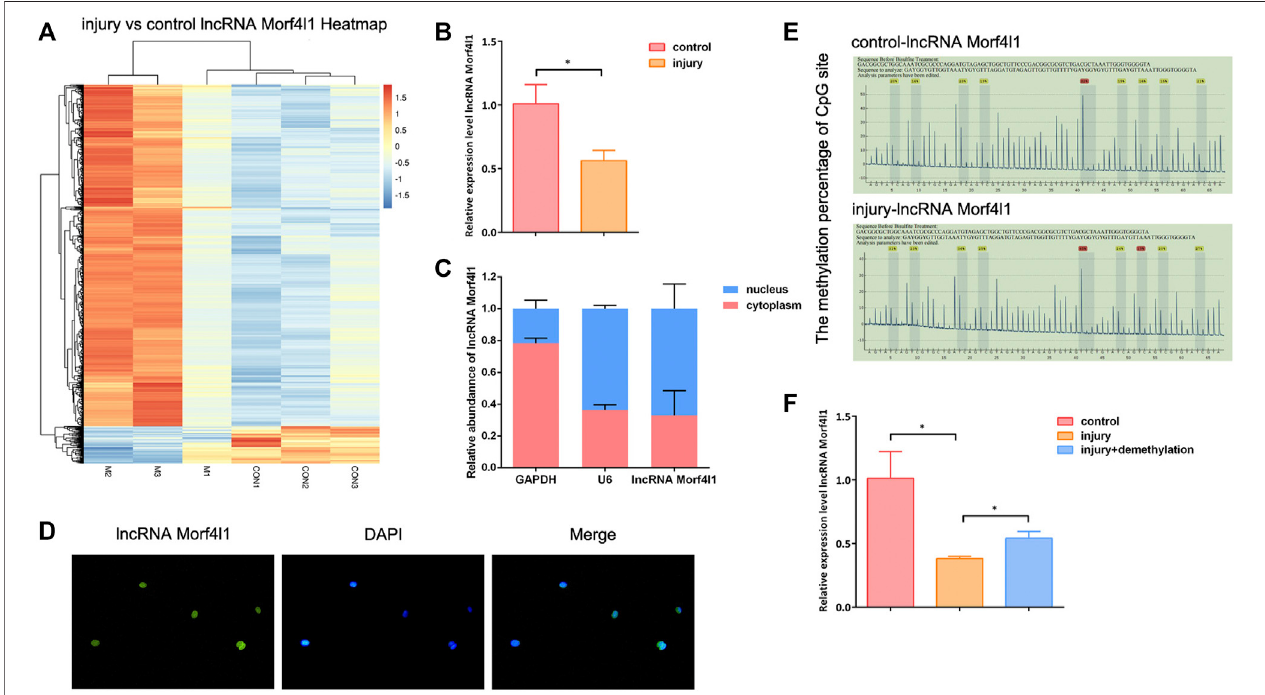
FIGURE1| LncRNAMorf4l1washypermethylatedininjuredtendontissues. (A) HeatmapclusteringofthedifferentiallyexpressedlncRNAinnormaltendontissues and injuredtendon tissues.Columns: individualsamples;rows:lncRNA;blue: lowexpression; orange:highexpression (B) qRT-PCRassaywasperformedtodetectthe expression of lncRNA Morf4l1 in normal tendon tissues and injured tendon tissues (C,D) Nucleus-cytoplasm separation and RNA-FISH assay were used to determine lncRNAMorf4l1 subcellular localization. DAPI was used to stain nuclei (blue); Left: green fl uorescence was from the biotin fusions; Right: the merged image; Base magni fi cation:×400 (E) Pyrosequencing report showed that the methylation level of the lncRNAMorf4l1 promoter region was higher in injured tendons compared with normal tendons. Gray: the actual detection of the fl uorescence signal intensity of the methylation site C/T; Yellow: the internal reference control, which was used to monitor the conversion ef fi ciency of sul fi te; Each peak is the fl uorescence intensity of the sequence to be tested, and the top percentage is the C/T fl uorescence signal ratio, that is, the methylation level of the methylation site to be detected (F) qRT-PCR assay was used to detect the expression of lncRNA Morf4l1 after demethylation of injured tenocytes ( n = 3; Mean ± SD, * p < 0.05, ** p < 0.01, *** p < 0.001; Student ’ s